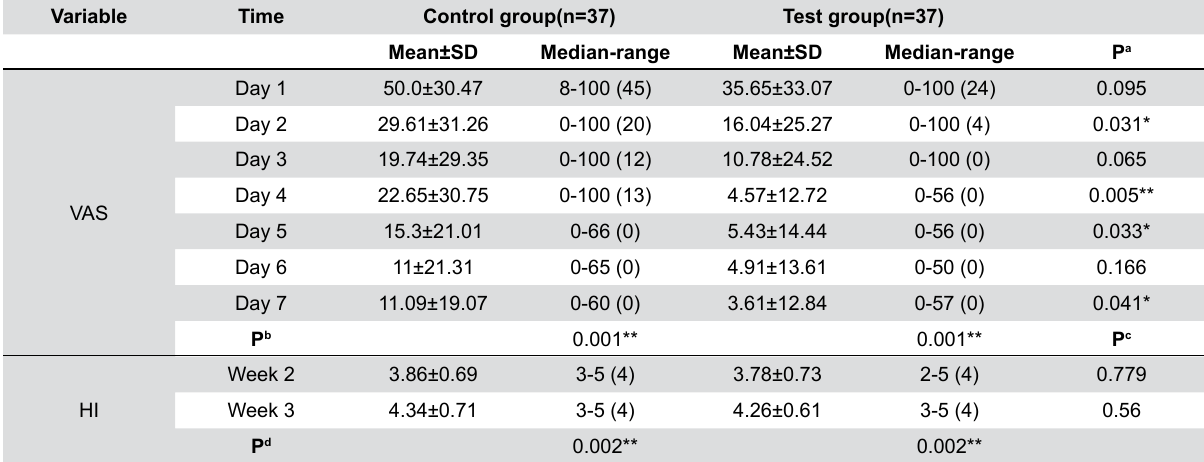
Table 3- Postoperative pain and healing